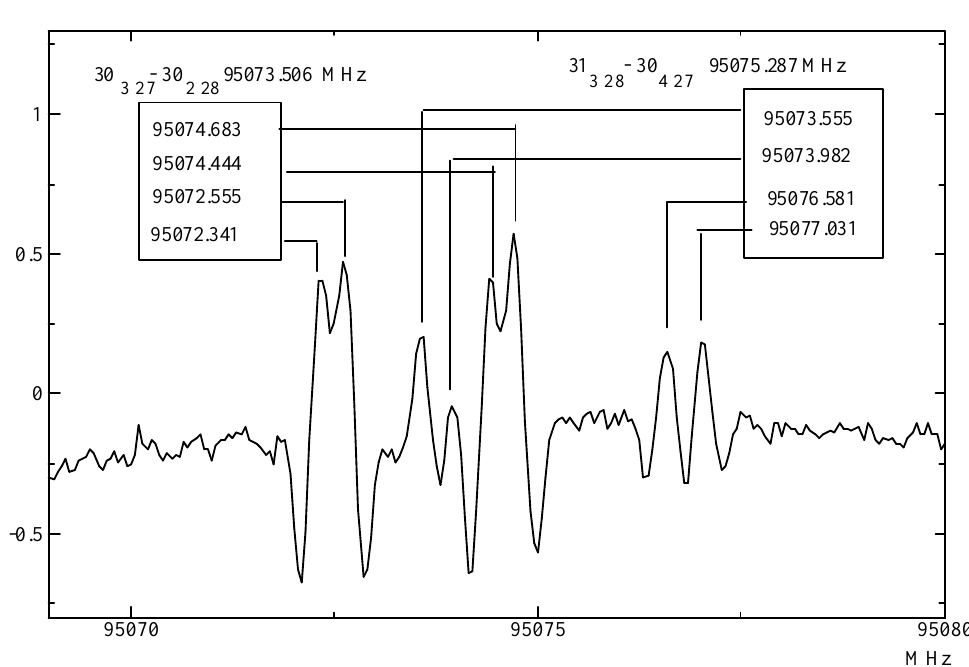
‹ 20 transition. 2 19 1 20